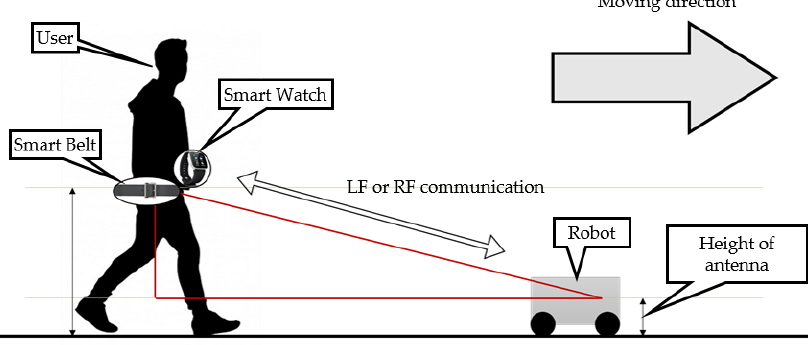
Figure 2. Overall setup of the Pet-Bot system.